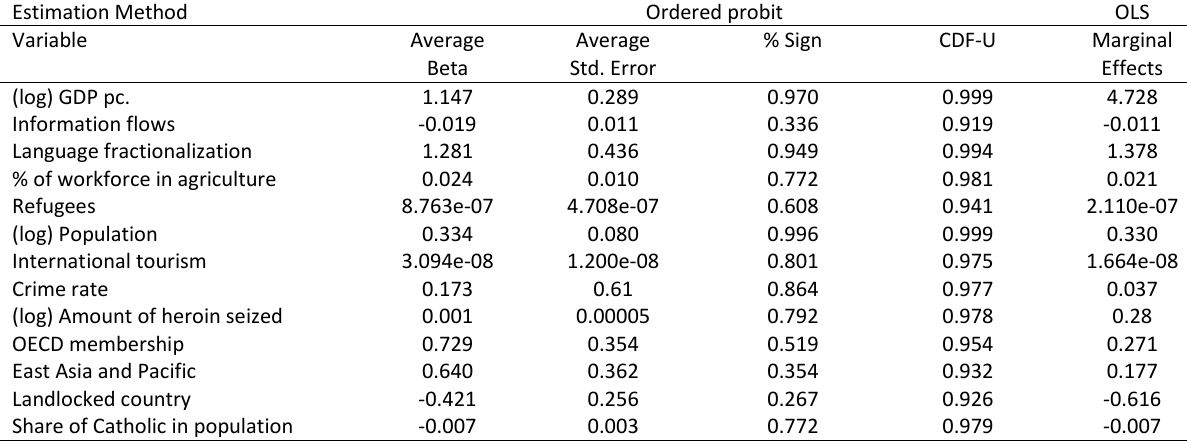
Table 2. Robust pull factors. Estimation Method